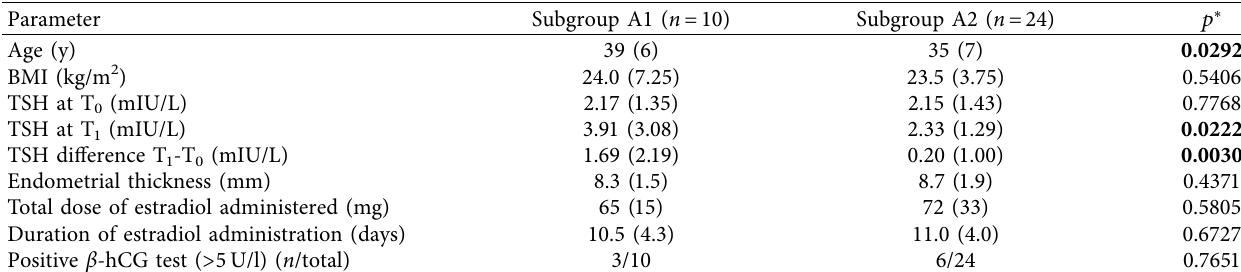
Figure 2: Distribution and trend of serum TSH values at T0 and T1 in groups A and B and in subgroups A1 and A2. Thick line indicates median values. Table 2: Characteristics of the patients, according to subgroups A1 and